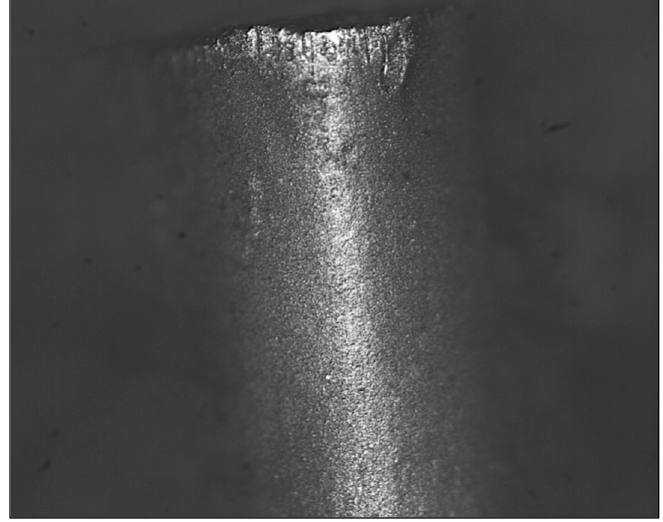
Figure 11. Tool flank wear after machining of LM 25 alloy.